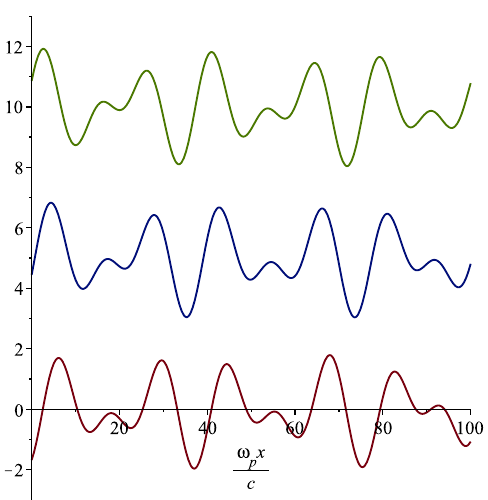
Figure 10. Transmitted wave motion from the bottom to the top for ω p t ranging from 5 to 7 in the steps of 1. The phase velocity has the backward direction.